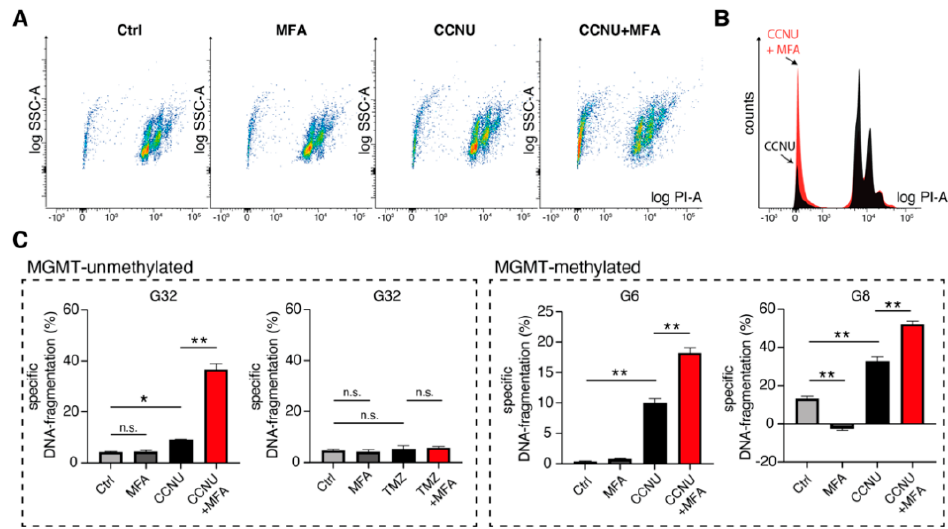
Figure 5. Meclofenamate sensitizes glioblastoma cells to lomustine-mediated cell death. ( A ) Representative scatter plots from flow cytometric analysis of propidium-iodide stained nuclei for G32 cell population for indicated treatment conditions. ( B ) Histogram overlay of flow cytometric analysis for CCNU treatment and combination treatment with MFA. ( C ) Mean ± SEM of specific DNA-fragmentation rates for MGMT-unmethylated (left) and MGMT-methylated (right) cell populations after 144 h of treatment. Treatment was performed with either CCNU, MFA or the combination of both. In case of MGMT-unmethylated cell population G32 cells were additionally treated with TMZ and the combination of TMZ with MFA. * and ** denote p < 0.05 and p < 0.01. CCNU,